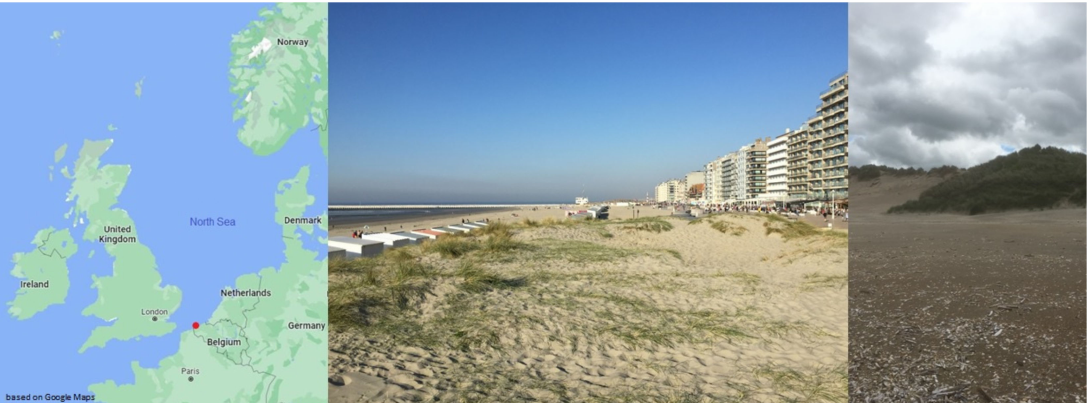
Figure 1. The Belgian West Coast is situated in the south of the North Sea (indicated with a red dot on the map). It is a sandy coast with dunes, either low crested (artificial situation in coastal towns) or with a higher, natural crest.